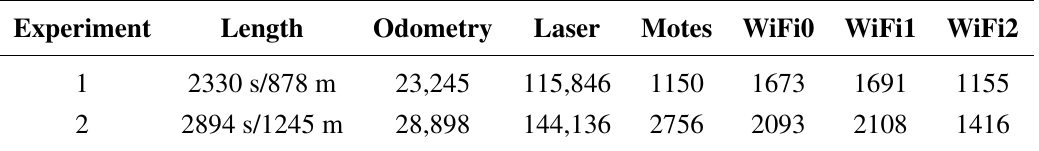
Table 1. Summary of each experimental trajectory: length (in seconds and meters) and the number of readings of the odometry, laser and